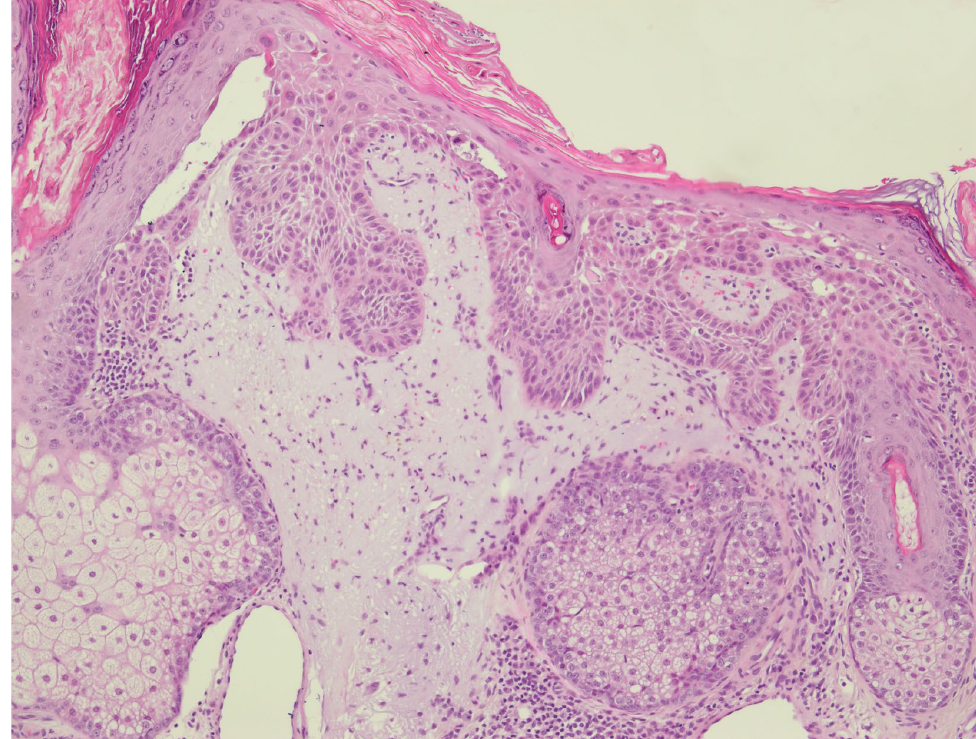
Figure 1. Histological section (H&E; original magnification ×40) of an actinic keratosis (AK) derived from a solid organ transplant recipient (sOTR) showing marked basal proliferation (PRO III), acan- tholysis, follicular involvement and pronounced solar elastosis. Marked basal proliferation (PRO III) and acantholysis were more prevalent in AKs from sOTRs than in the immunocompetent control group ( p < 0.0001 and p < 0.0001, respectively).